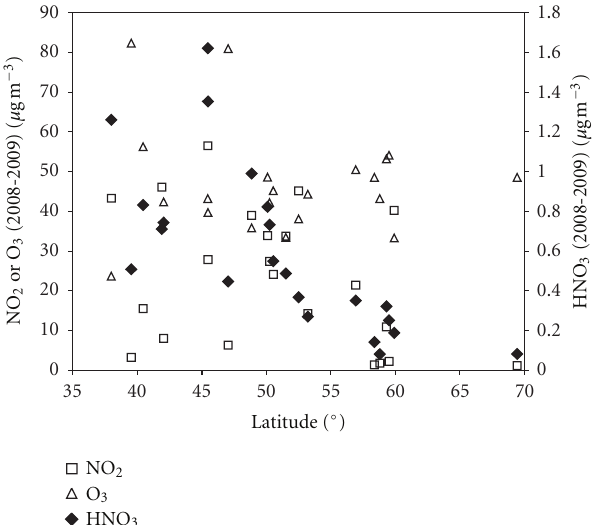
Figure 8: The concentration of nitric acid during 2008/09 and two of its precursors as a function of latitude.